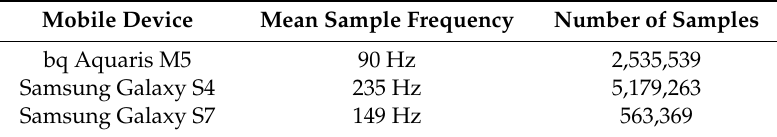
Table 1. Android smartphones used for gathering data.